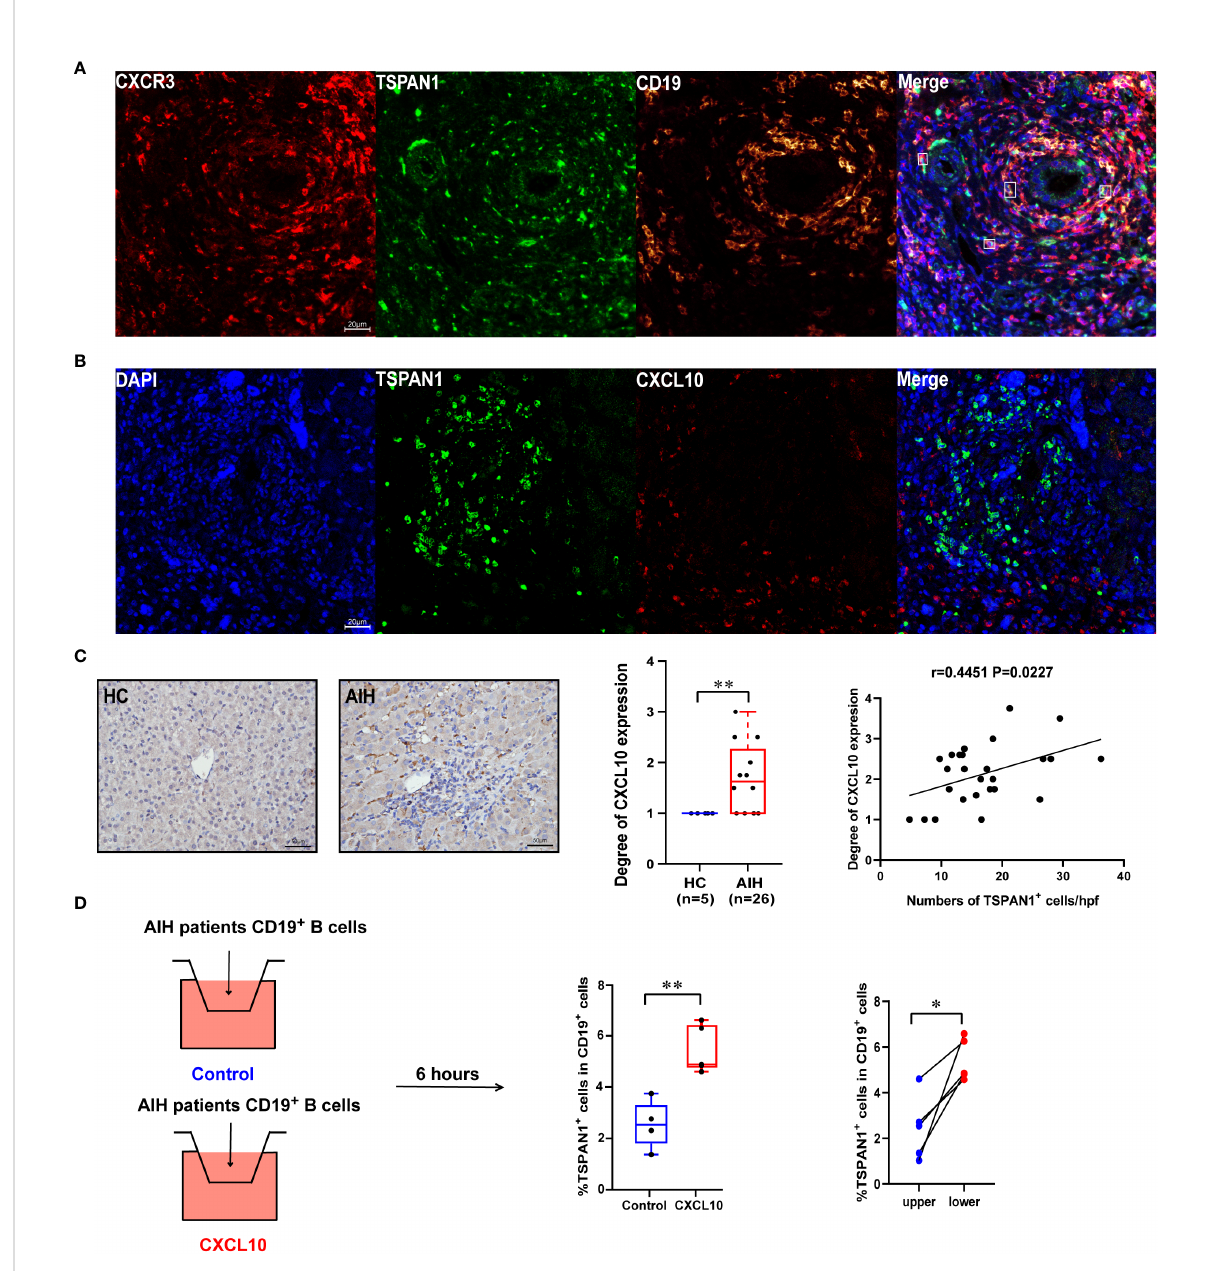
FIGURE 6 The expression of CXCR3 and CXCL10 in AIH. (A) Multiplex immuno fl uorescence staining of CXCR3 (red), CD19 (yellow), and TSPAN1 (green) in the liver of AIH patients. (B) Representative confocal staining of TSPAN1 and CXCL10 in the livers of AIH. (C) Immunohistochemical staining of CXCL10 in AIH and HC (×400). Correlation analysis of hepatic CXCL10 expression degree with the numbers of TSPAN1. (D) CD19 + B cells were placed in the upper chambers and complete medium was added in the lower chambers with rhCXCL10 (3 m g/mL) or not for 6 hours. The percentage of TSPAN1 + cells was measured by fl ow cytometry. Boxes represent the 25th – 75th percentile of the distribution; the median is shown as a thick line in the middle of the box; whiskers extend to values with 1.5 times the difference between the 25th and 75th percentiles. * P < 0.05, ** P <